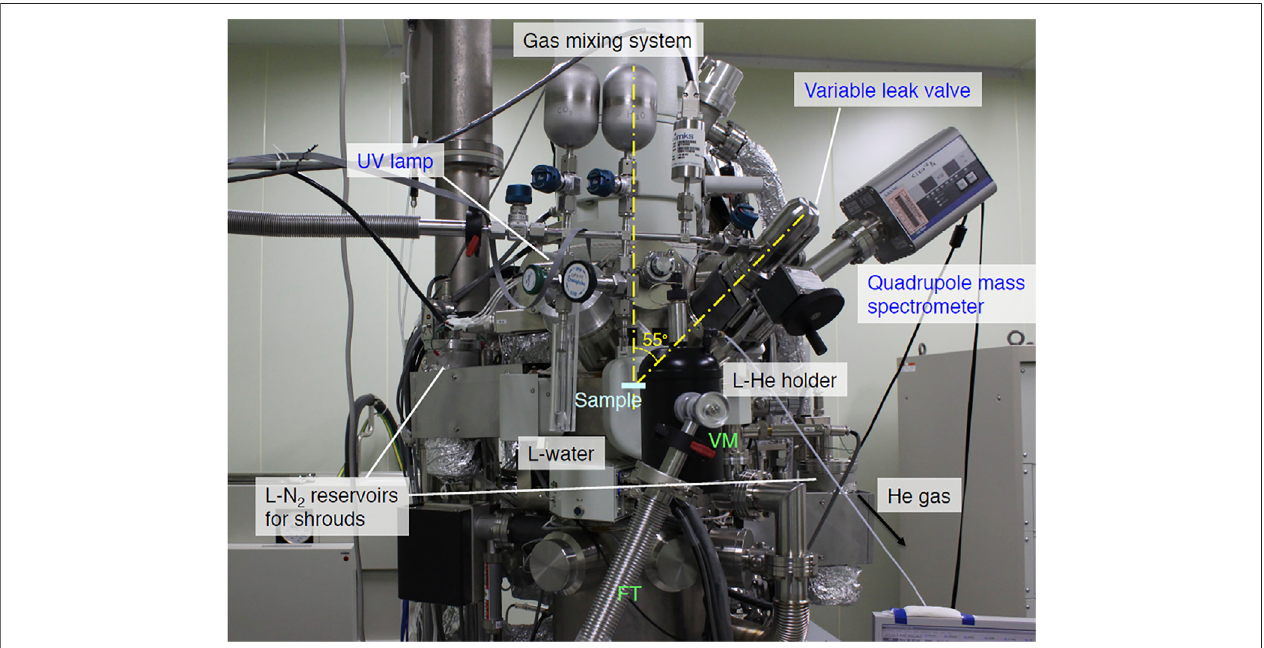
FIGURE 2 | A front view around the specimen holder and gas mixing